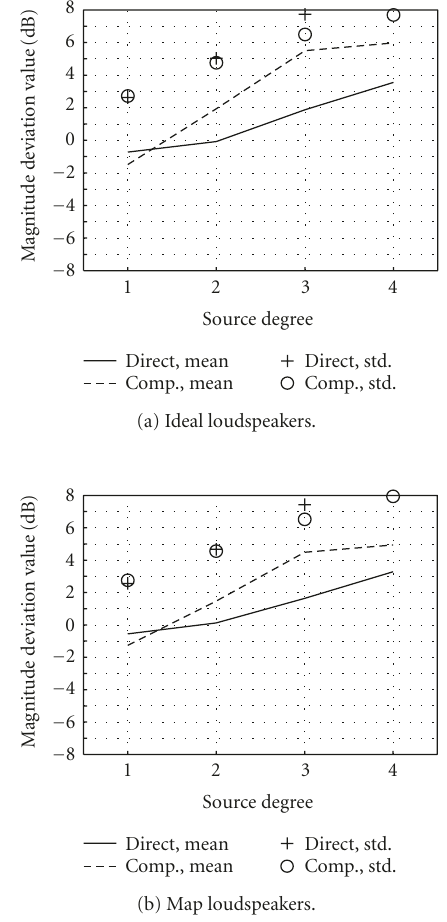
Figure 18: Mean value and standard deviation of MAG Ψ ated below the aliasing frequency for all microphone and source positions. Synthesis of “combined” directivity (cf. (23)). Compar- ison between recomposition from elementary directivity (comp) and direct synthesis (direct). All filters are calculated using individ- ual equalization + average synthesis error compensation (AvCo).